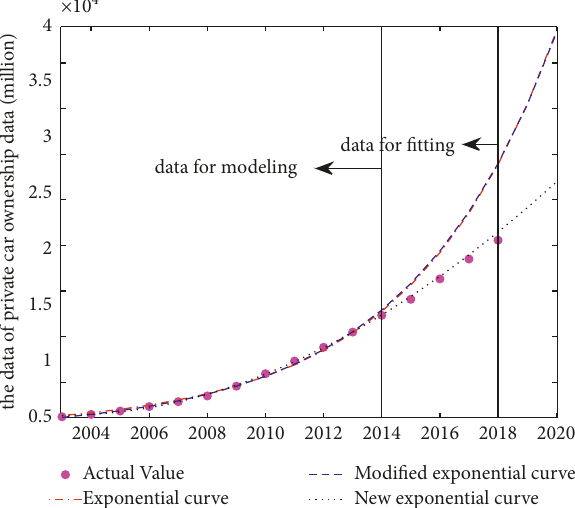
Figure 1: Fitting and prediction of private car ownership data by exponential curve, modified exponential curve, and new expo- nential curve with first-order polynomial term.